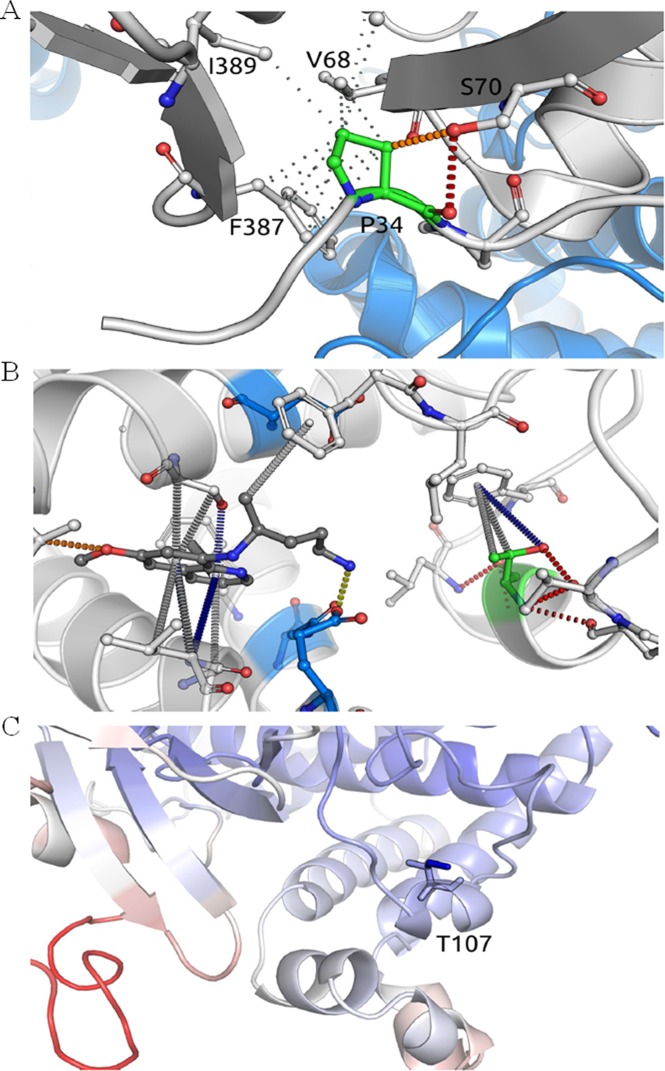
Analysis of the molecular interactions of polymorphic residues of CYP2D6 and their effects on the metabolism of primaquine.(A) The residue P34 has a buried side chain that is inserted into a predominantly hydrophobic environment (the hydrophobic interactions are depicted as gray dots) and is performing a main-chain to side-chain polar interaction with a neighboring beta strand (red dashes). The mutation P34S is predicted to destabilize the protein because it disrupts the local hydrophobic interaction network and affects the backbone rigidity. (B) The interactions for docked PQ (dark gray) and residue T107 (green). Threonine 107 is located in the vicinity of the PQ binding pocket (6.1 Å from PQ) and also nearby important catalytic residues (depicted in blue). (C) The mutation T107I results in the formation of increased local interactions, reducing CYP2D6 flexibility. Residues are colored based on their predicted effect on flexibility, ranging from more flexible (red) to less flexible (blue).